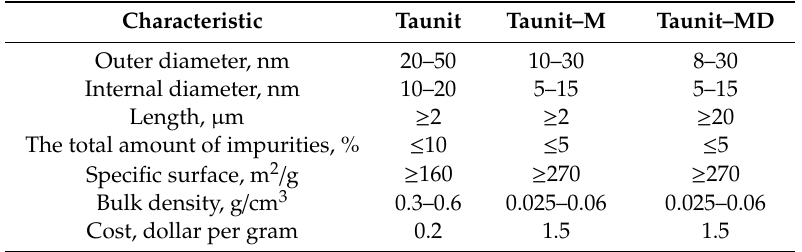
Table 1. Characteristics of MWCNTs of various grades from the manufacturer.